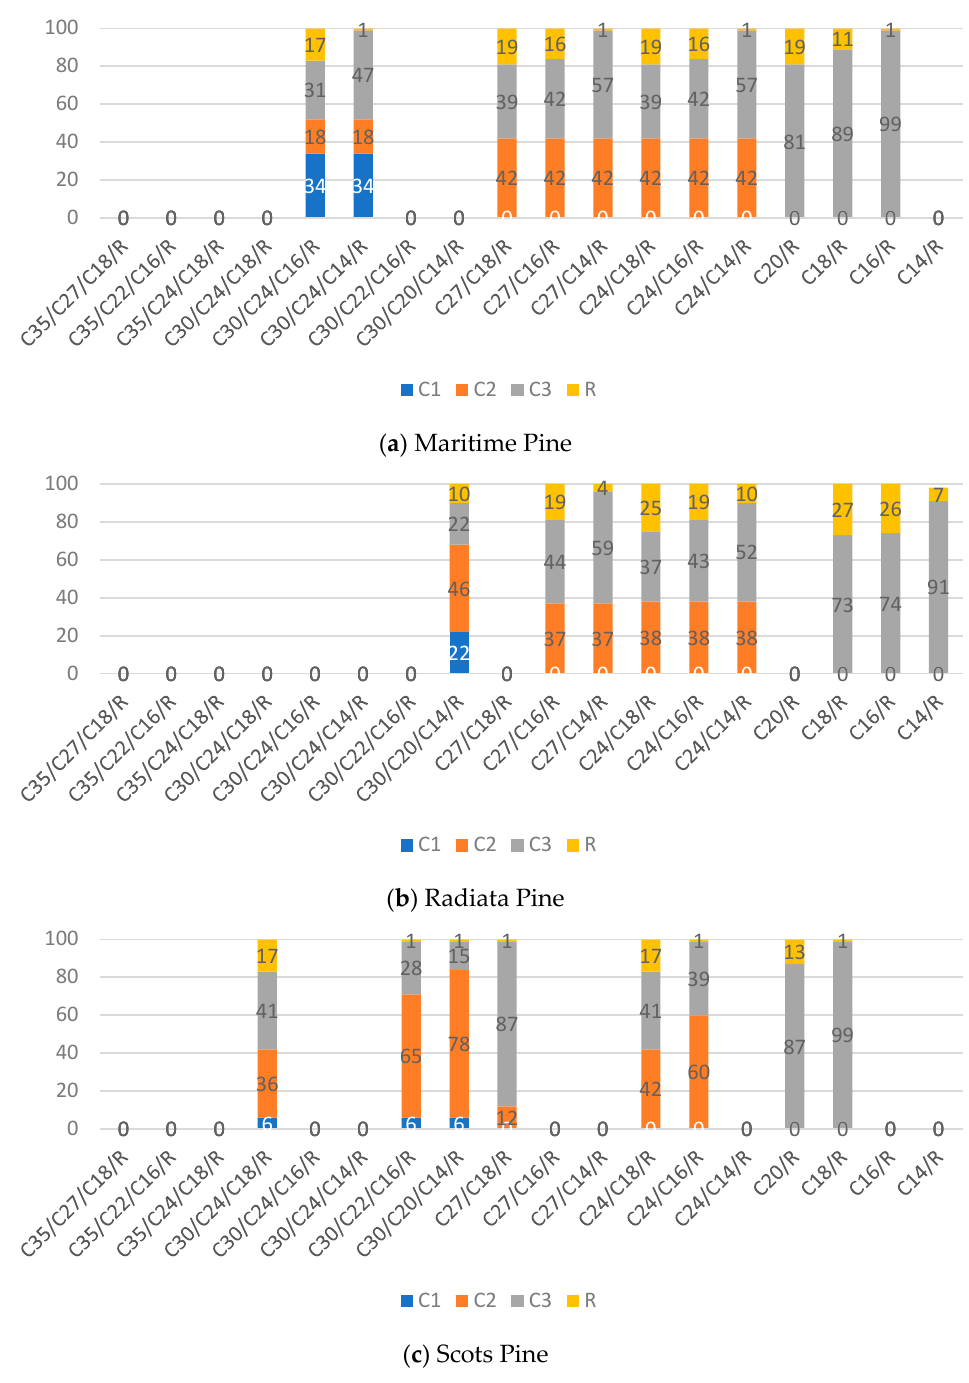
Figure 7. Yields (%) obtained for handheld grading machines by strength class by species. Note: Empty columns reflect that the strength class combination did not provide a better yield with respect to the immediately higher strength class combination.